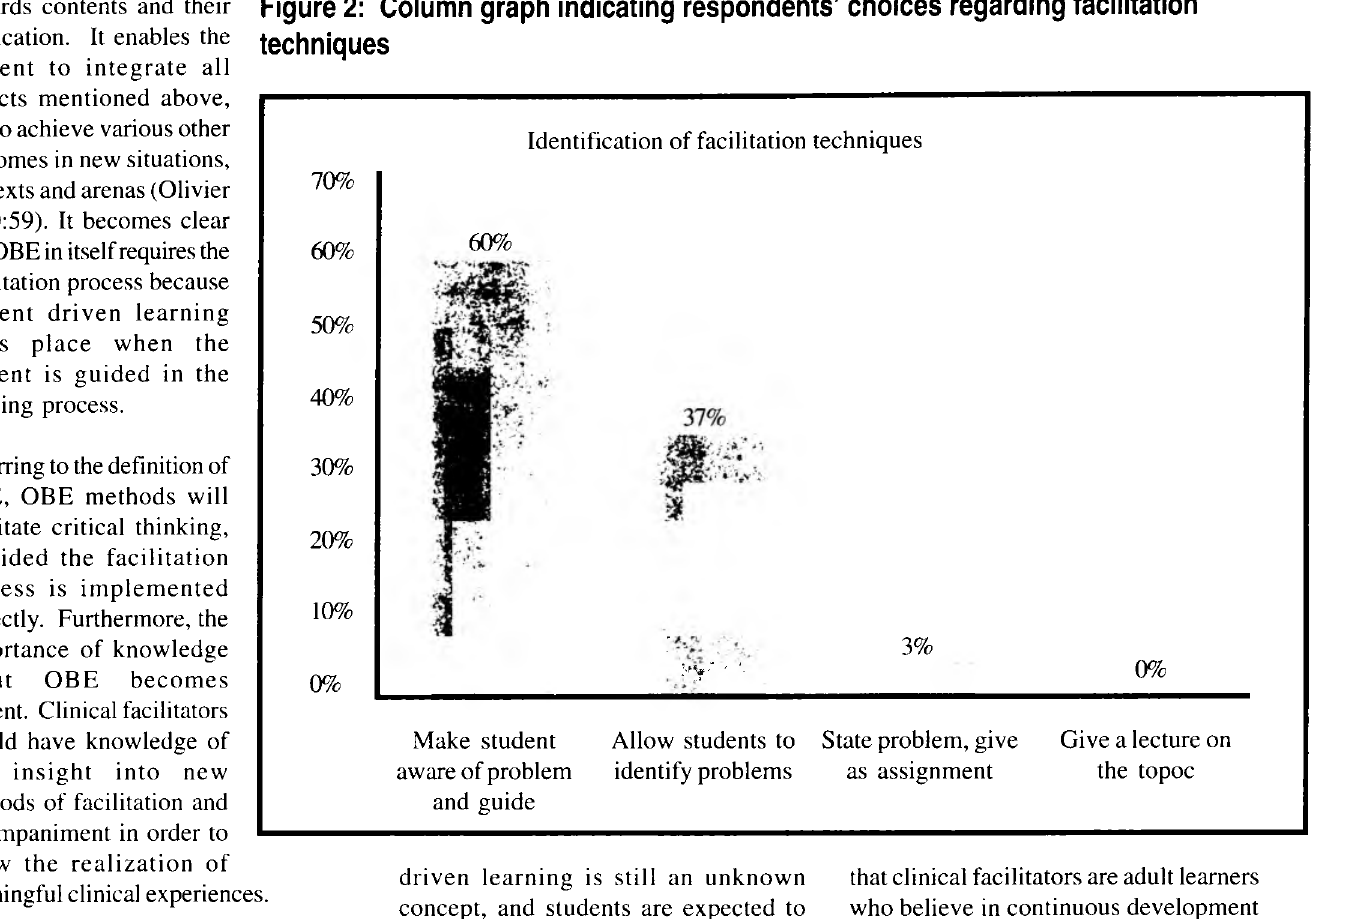
Figure 2: Column graph indicating respondents’ choices regarding